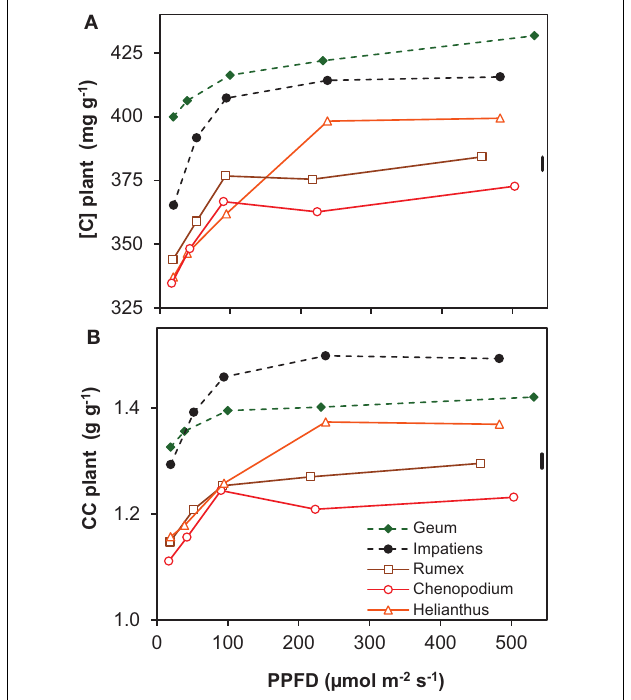
FIGURE 3 | Chemical composition of whole-plant dry matter of five species grown at five irradiance levels (PPFD). (A) Carbon concentration in whole-plant dry matter ([ C ]); (B) construction costs (CC) of whole-plant dry matter calculated from the chemical composition. Means ( n = 2 bulk samples) and the common standard deviation (sd) are shown. The chemical composition from which the CC was derived is shown in